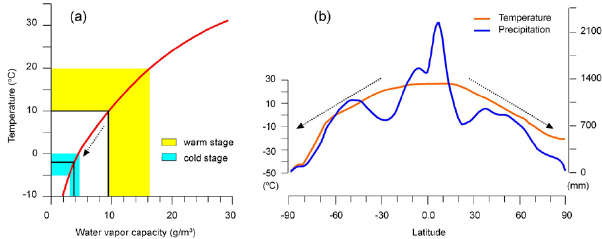
Fig. 9. Plots showing (a) water vapor capacity at saturation (11% relative humidity) versus temperature (Oard, 1990) (note the 60% drop in capacity as temperature decreases from 10 to − 2 ◦ C (black line); highlighted areas show the vapor capacity in the warm Miocene (yellow) and cold Pleistocene (blue) according to de Boer et al. (2010) (arrow showing the exponential relationship between cooling and water vapor capacity reduction), and (b) variations in MAT and MAP as a function of latitude for the present day (Haywood et al., 2000) (arrow indicating the general relationship between cooling and precipitation reduction).